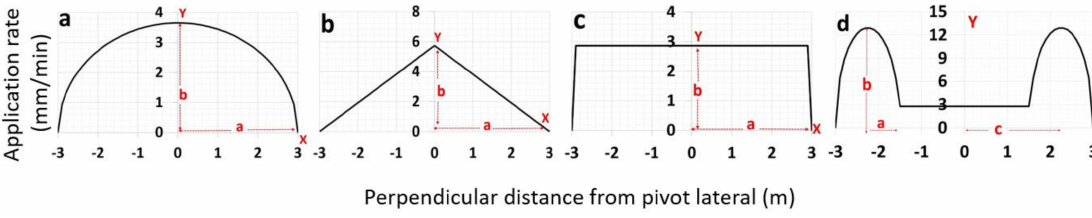
Figure 2. Different sprinkler water application patterns: elliptical ( a ), triangular ( b ), rectangular ( c ), and donut ( d